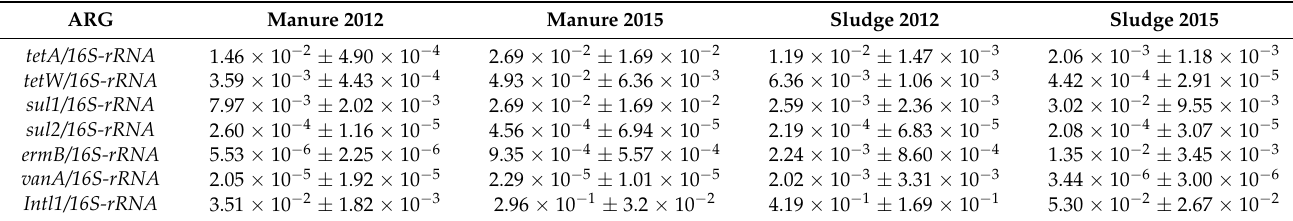
Table 1. The relative abundances of ARGs in fertilizers applied in the years 2012 and 2015. Grey highlights mean that the relative abundances of ARGs in manure or sewage sludge did not statistically differ (one-way ANOVA, p ≥ 0.05) between the years 2012 and